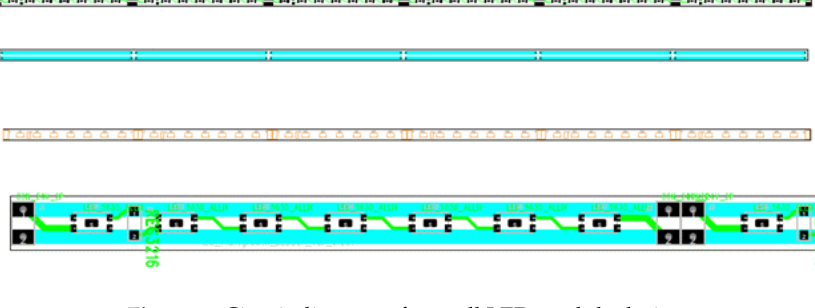
Figure 7. Plant growth LED module design single circuit. Figure 8. Circuit diagram of overall LED module design.